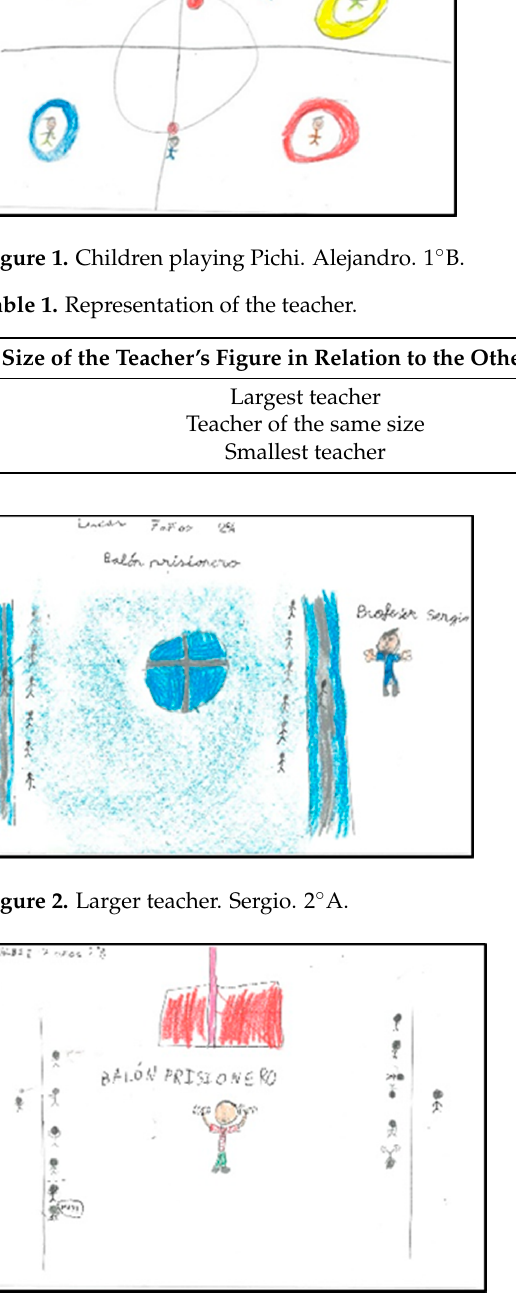
Figure 1. Children playing Pichi. Alejandro. 1°B.